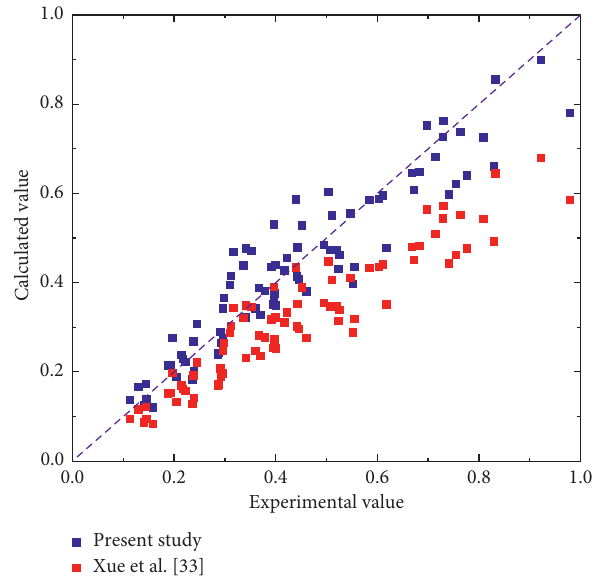
Figure 10: Experimental and calculated values of the impulse wave